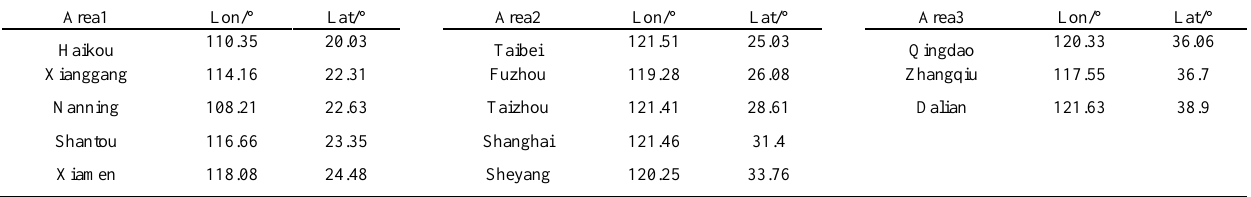
Tab 1 .Detailed coordinate table of 13 radiosonde stations in eastern